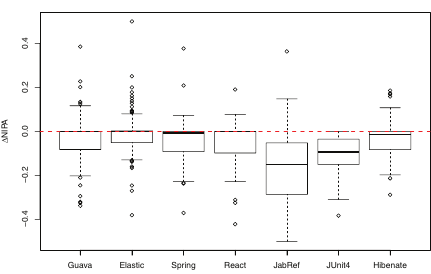
Fig. 2. Boxplots of Δ NIPA ( v ) (focused only on the range [ − 0 . 5 , 0 . 5 ]